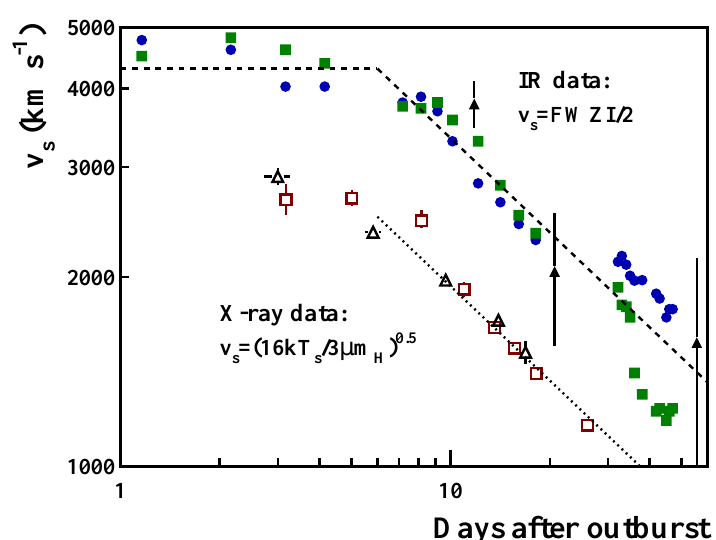
Fig. 1. Time-dependence of forward shock velocity in the 2006 outburst of RS Oph as deduced from FWZI of IR emission lines (filled squares and circles: Das et al. 2006, filled triangles: Evans et al. 2007) and X-ray measurements of the post shock temperature (open triangles: Sokoloski et al. 2006, open squares: Bode et al. 2006). The IR data can be modeled by (dashed line) v s ( t ) = 4300( t=t 1 ) (cid:11) v km s (cid:0) 1 , where t 1 = 6 days and (cid:11) v = 0( (cid:0) 0 : 5) for t (cid:20) t 1 ( t > t 1 ).